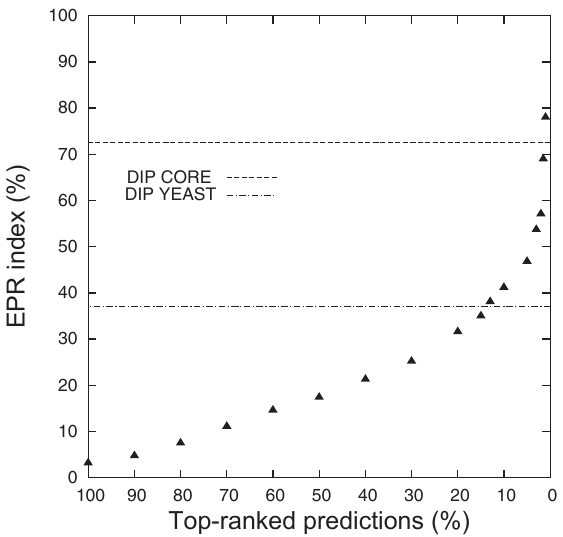
Figure 5. EPR Index in Predictions of Interactions. The black triangles indicate the EPR index for the predicted interactions for top- ranked scores. For example, the set of top 10% predictions has EPR index 41.2.